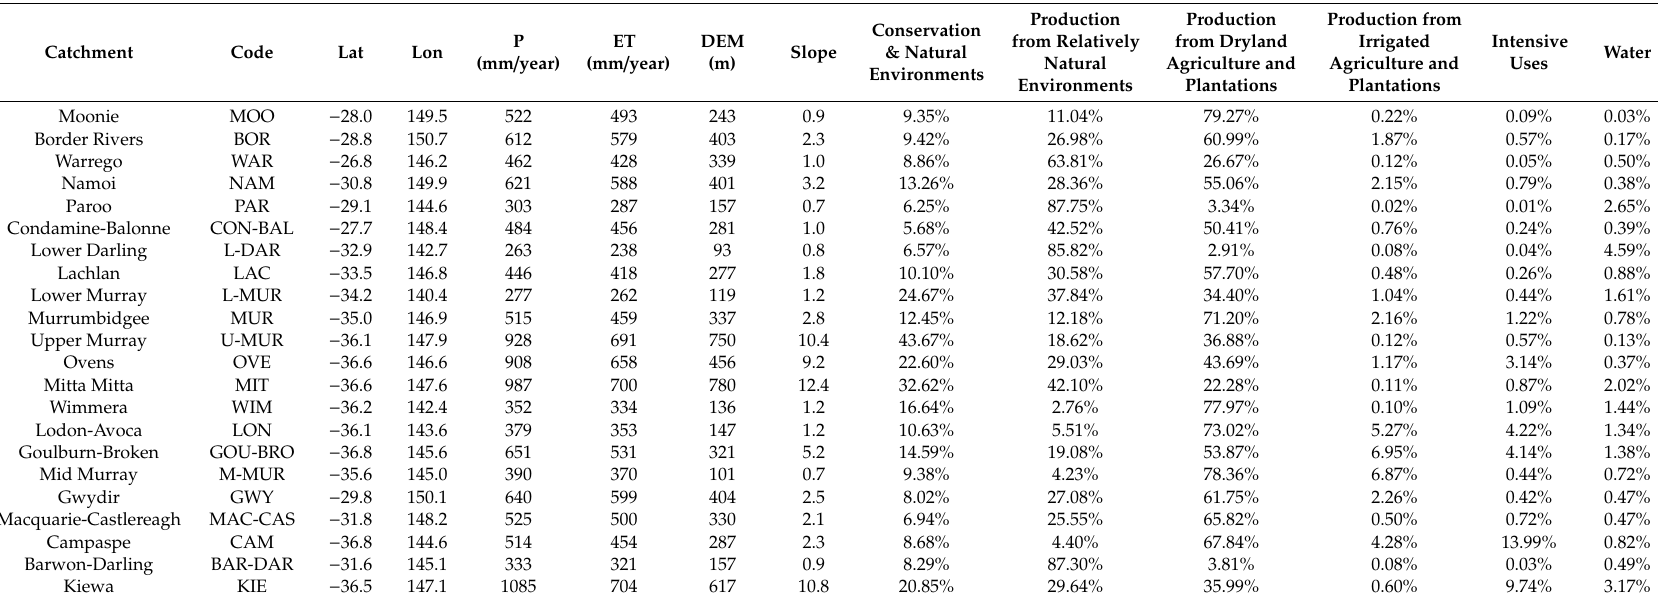
Table 1. Summary of catchment characteristics in the Murray Darling Basin. Catchment scale precipitation (P) and evapotranspiration (ET) are summarized from the Australian Water Availability Project (AWAP) data product, and terrain metrics (digital elevation model (DEM) and slope) are calculated with the Shuttle Radar Topography Mission (SRTM) 90 m digital elevation